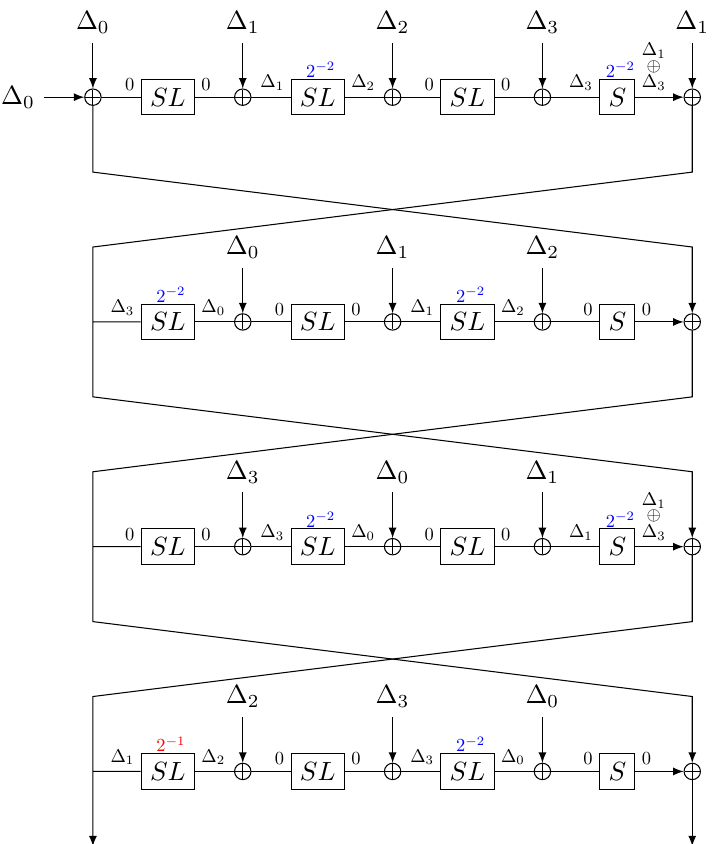
Figure 4: Four-round iterative differential characteristic against RoadRunneR